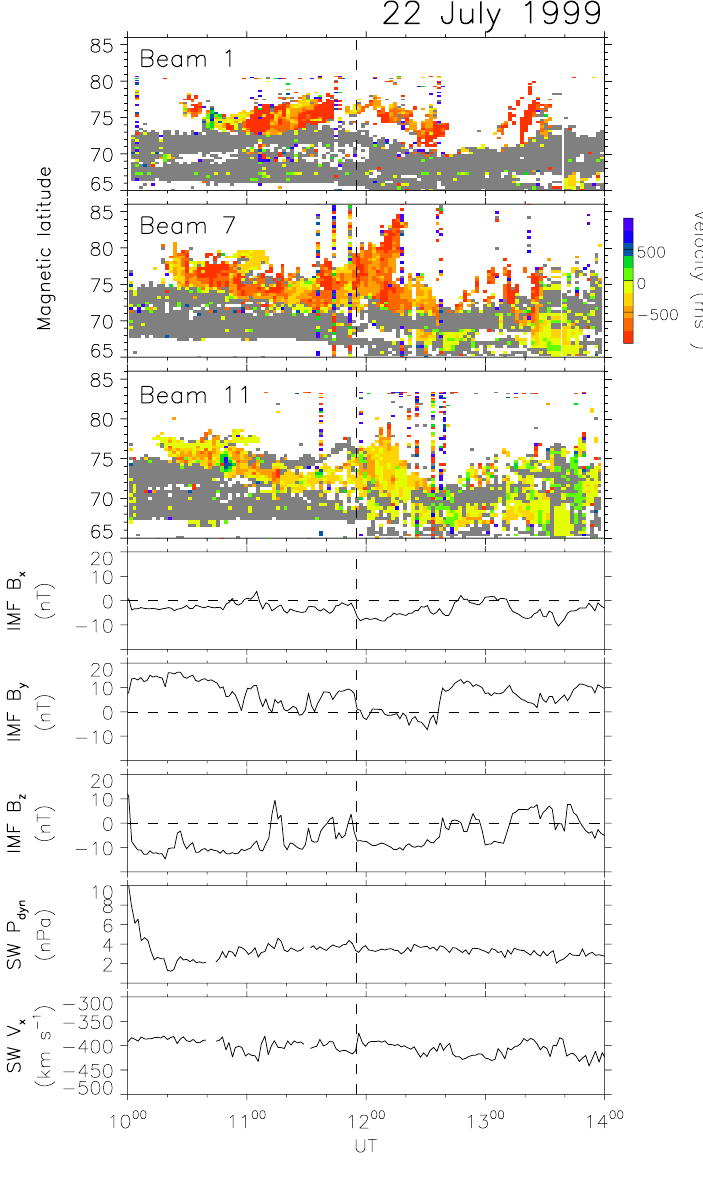
Fig. 9. Similar to Fig. 6, though for the 22 July 1999